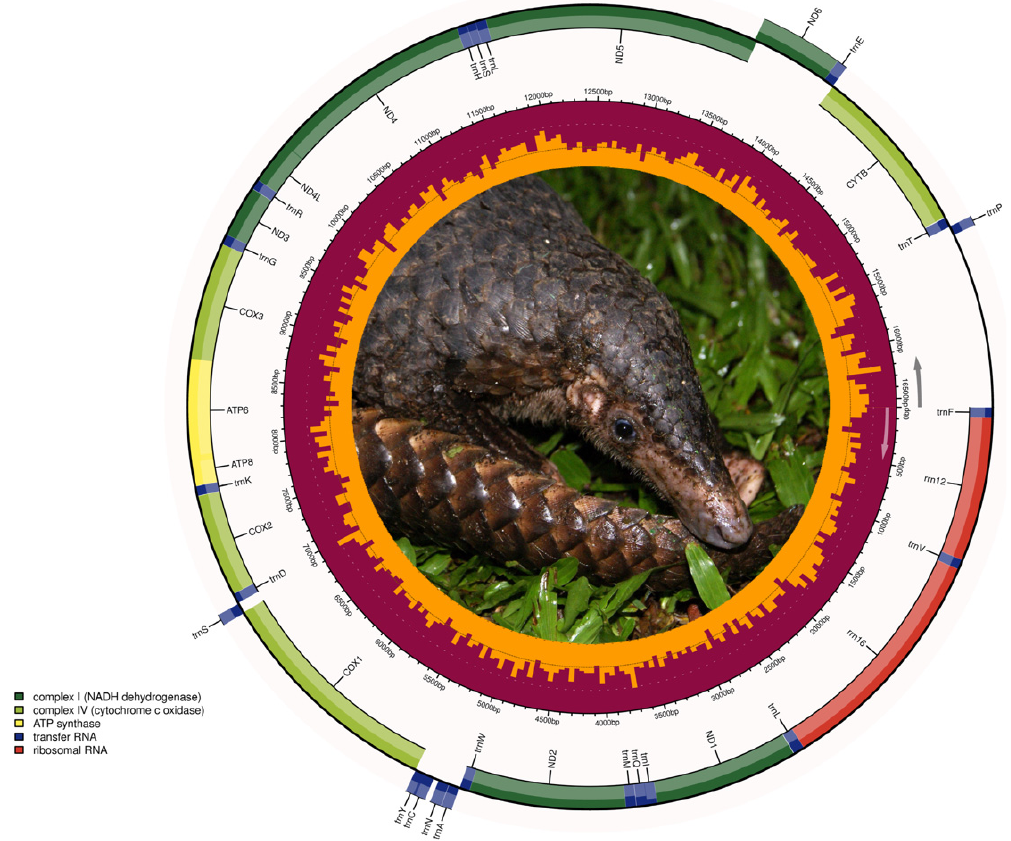
Figure 1. Circular DNA mitochondrial genome map of the Java pangolin ( Manis javanica ) assembled from eDNA scats. The annotated map depicts 13 protein-coding genes (PCGs), two ribosomal RNA genes (rrnS: 12 S ribosomal RNA and rrnL: 16 S ribosomal RNA), 22 transfer RNA (tRNA) genes, and the putative control region (not annotated). Mitochondrial genome structure was most similar among the different species analyzed. Photo credit: Firman/INaturalist, CC BY. https://www.inatu- ralist.org/guide_taxa/178736 (accessed on 28 August 2022).